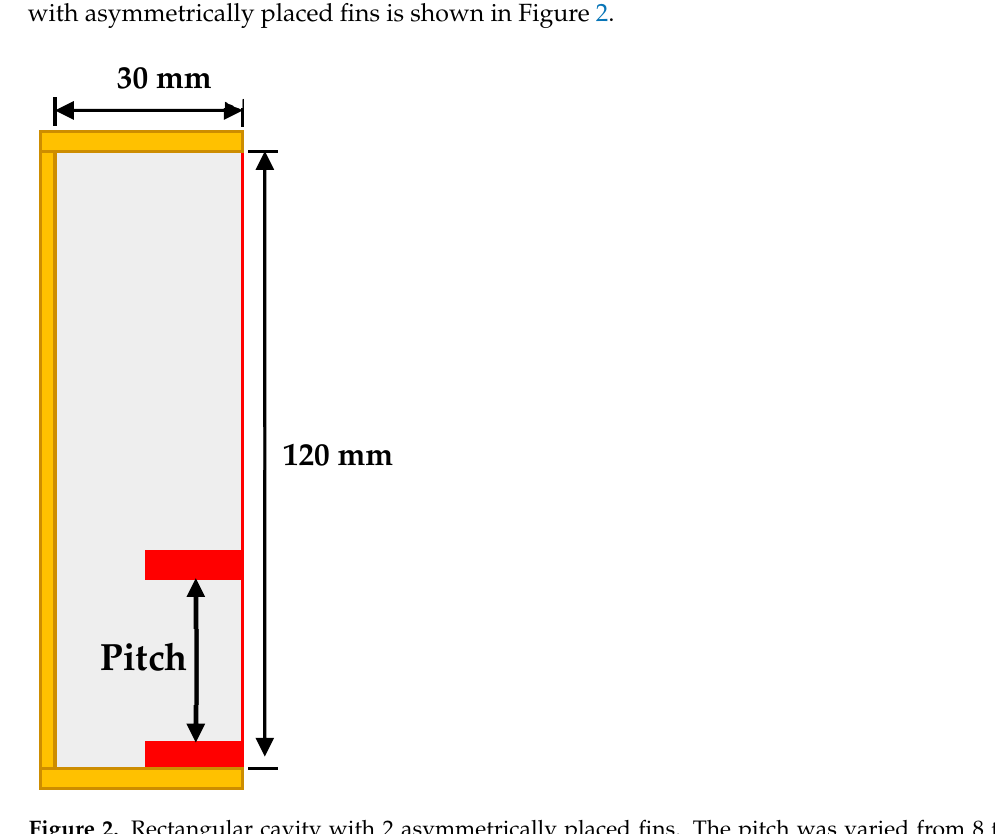
Figure 2. Rectangular cavity with 2 asymmetrically placed fins. The pitch was varied from 8 to 54 mm.